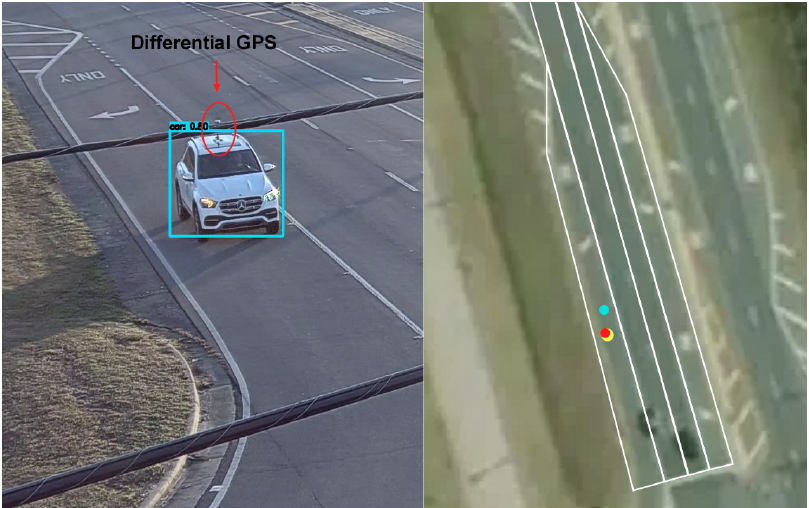
Figure 7 . A vehicle equipped with a di ff erential GPS receiver and its location in an aerial view map . Figure 7. A vehicle equipped with a differential GPS receiver and its location in an aerial view map. Table 2. Comparison of vehicle localization error with respect to differential GPS measurement in the world coordinates with and without center correction by a linear regression